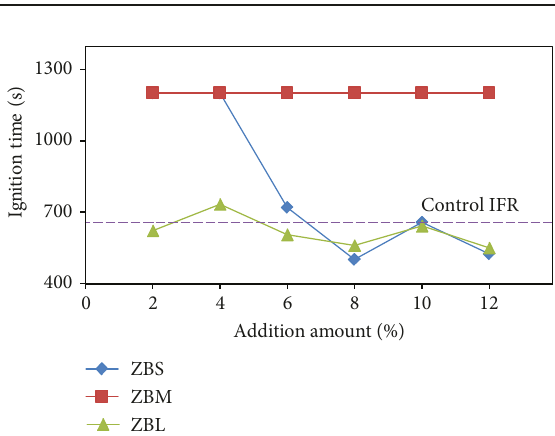
Figure 1: Ignition time of wood treated with IFR/ZB